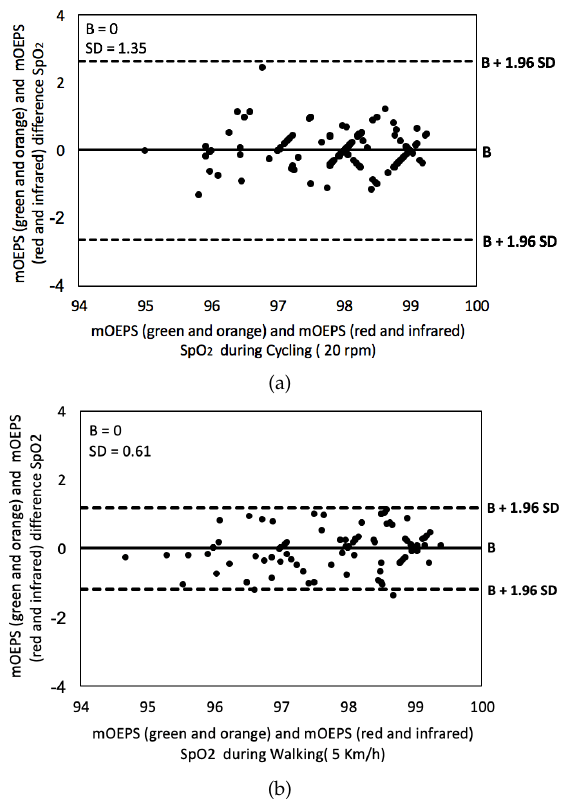
Figure 10. Bland–Altman plot showing differences in SpO 2 between the green and orange illuminations of mOEPS and the red and infrared illuminations of mOEPS for ( a ) cycling and ( b ) walking. The graphs display a scatter diagram of the differences against the averages of the green/orange and red/infrared illuminations of mOEPS for 16